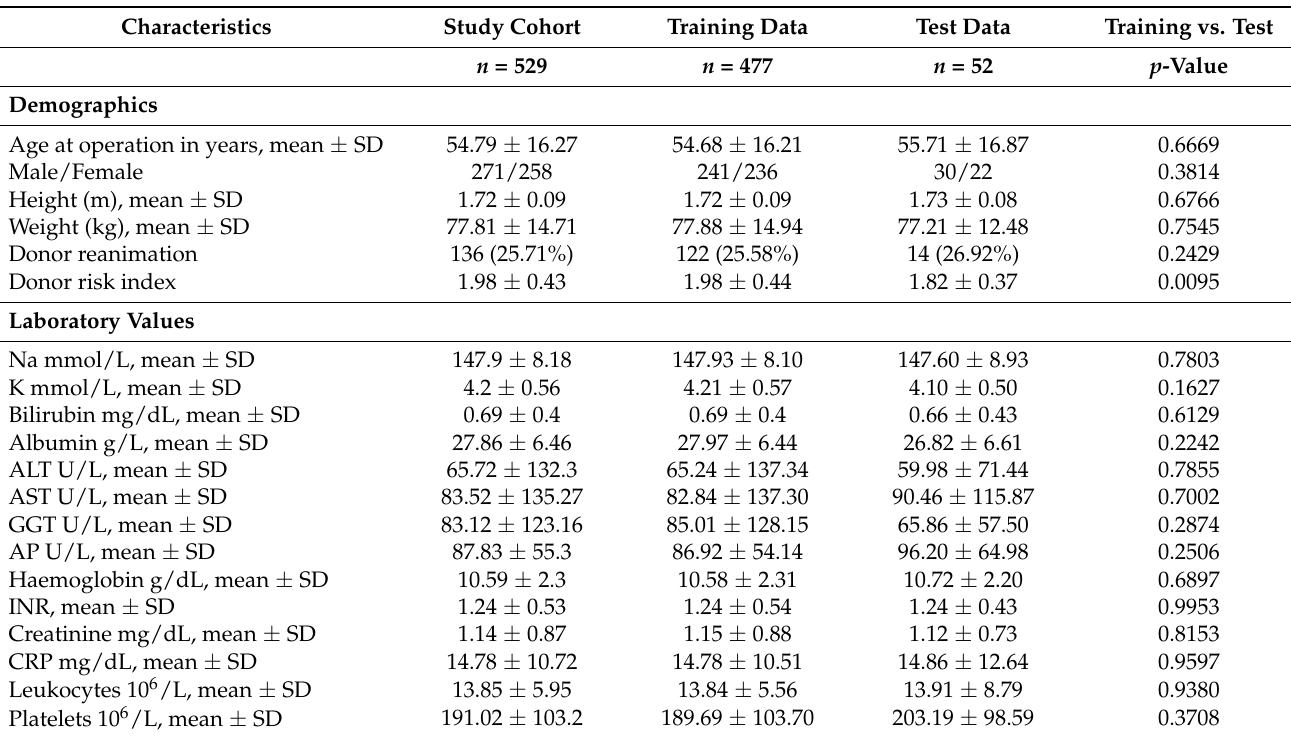
Table 3. Study data from the donor study cohort before transplantation. Training and test data are